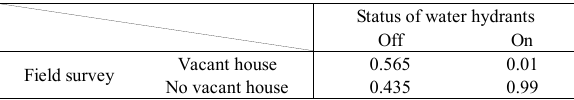
Table 2. Comparison between the status of water hydrants and